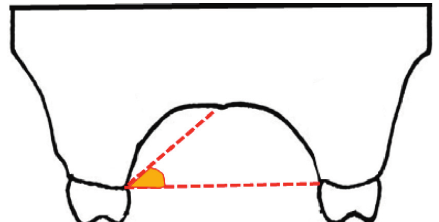
Figure 1: Palatal vault angle on the maxillary first molar was measured using the junction angle between the horizontal plane at the cementoenamel junction (CEJ) and an imaginary line from the midpalatal suture to the CEJ.